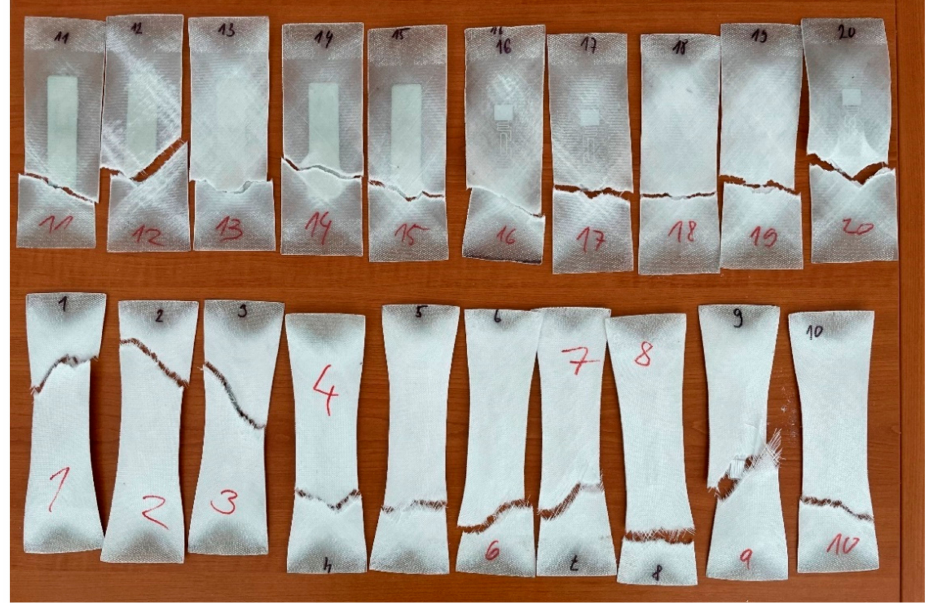
Figure 17. Course of damage for individual tested samples.